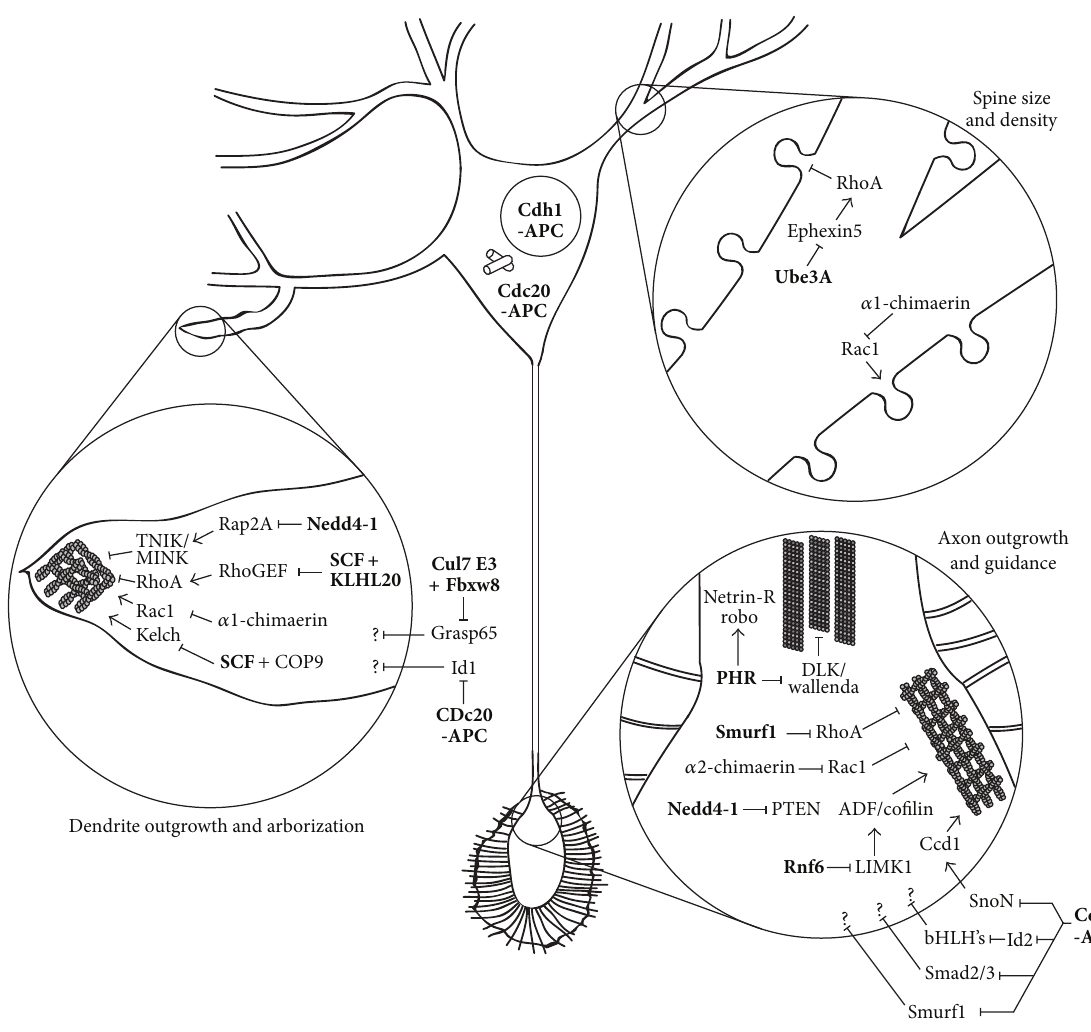
Figure 2: The ubiquitin-proteasome system in regulation of neural morphogenesis. Known signaling cascades for ubiquitin-dependent regulation of the formation of axons (bottom right inset), dendrites (left inset), and dendritic spines (top right inset). Regulatory factors depicted outside of the insets represent signaling from the cell body, rather than local regulation. E3 ligases are depicted in bold; arrows represent positive regulation; bars represent inhibition or